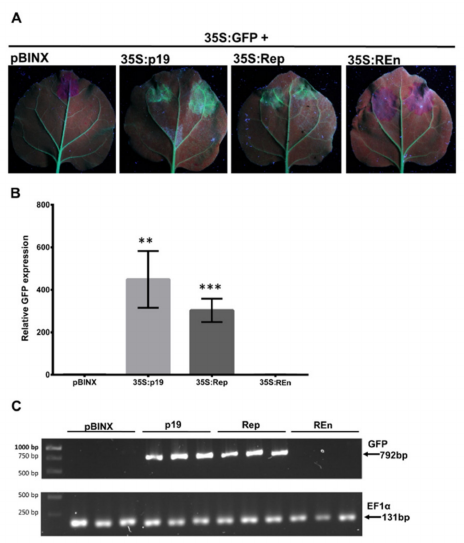
Figure 7. Post-transcriptional gene silencing (PTGS) suppressor silencing analysis. ( A ) N. benthamiana 16c plants were co-agroinoculated with a mixture of 35S:GFP plus pBINX empty vector or vectors expressing di ff erent viral proteins to be tested for PTGS suppression: 35S:p19, 35S:Rep, or 35S:REn. Five days after agroinoculation plants were evaluated for GFP fluorescence under UV light. ( B ) Quantification of GFP RNA expression by RT-qPCR. GFP RNA expression levels were normalized using the expression of the internal gene NbEF1a. Bars represent the mean values for three independent biological replicates. Error bars represent standard deviation of the mean. Asterisks indicate samples that are statistically di ff erent to pBINX (** p < 0.01; *** p < 0.001; ns, not significant), determined by Student´s t -test. ( C ) A RT-PCR assay was carried out to detect the expression of the GFP gene